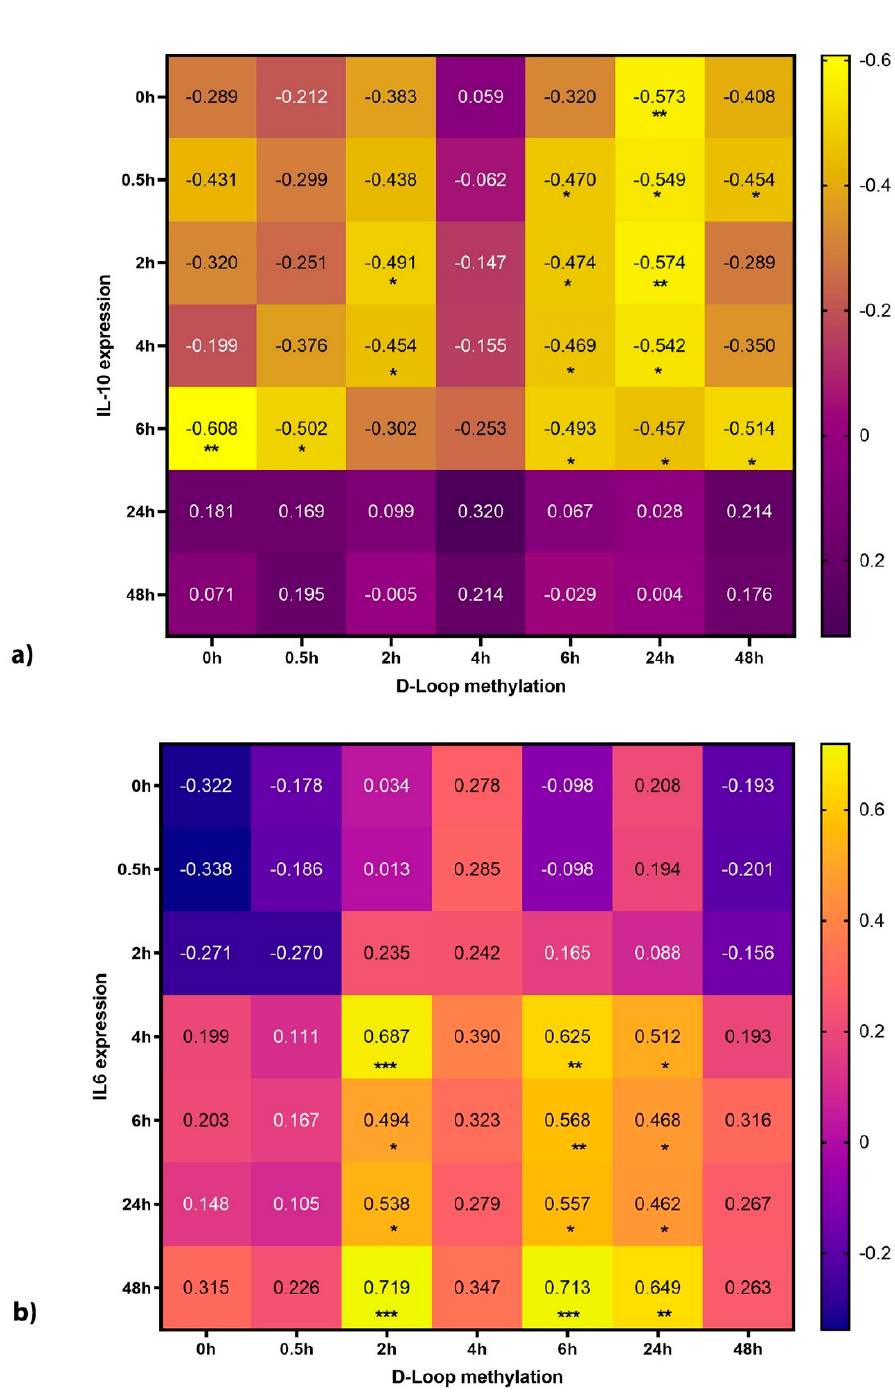
Figure 5. Correlation matrix of D-Loop methylation with IL-10 ( a ) and IL-6 ( b ). ( a ) Early (up to 6 h) IL-10 secretion correlates negatively with D-Loop methylation. Especially the early D-Loop methylation correlates well with 6 h of IL-10 secretion. In addition, later D-Loop methylation levels (6 h and 24 h) correlate well with early (up to 6 h) IL-10 values. ( b ) Correlation between IL-6 and D-Loop methylation is mostly between later time points. In general, earlier D-Loop methylation time points correlate better with later IL-6 time points. (Numbers depict correlation coefficient and *: p < 0.05, **: p < 0.01, ***: p < 0.001).